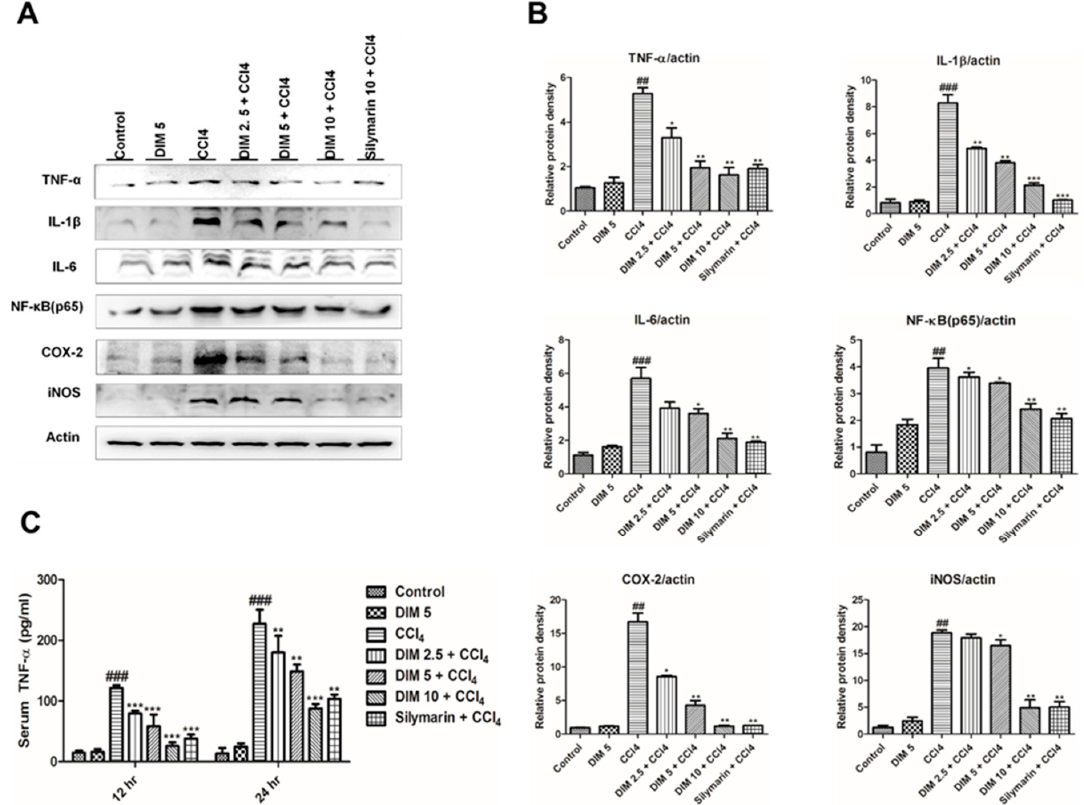
Figure 5. DIM pretreatment inhibits the protein expression levels of inflammatory factors in liver tissue of CCl 4 -induced liver injury in mice. ( A ) Protein expression of pro-inflammatory cytokines (TNF- α , IL-6 IL-1 β ) and inflammatory mediators (COX-2 and iNOS) at 24 h after CCl 4 injection by using Western blot analysis. ( B ) Quantification of relative protein expression normalized to β -actin. ( C ) The level of serum TNF- α measured using ELISA kits. The values represent the mean ± SD ( n = 3). ### p < 0.001 and ## p < 0.01 denotes significant differences compared to the normal control group, * p < 0.05, ** p < 0.01, *** p < 0.001 compared to the CCl 4 group.